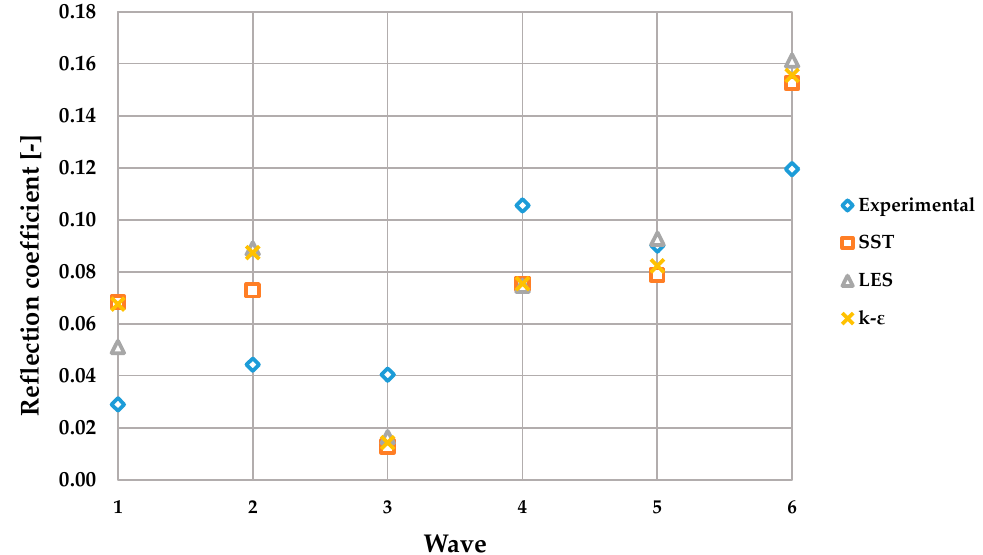
Figure 6. Reflection coefficients measured for each wave in the experimental and numerical runs.